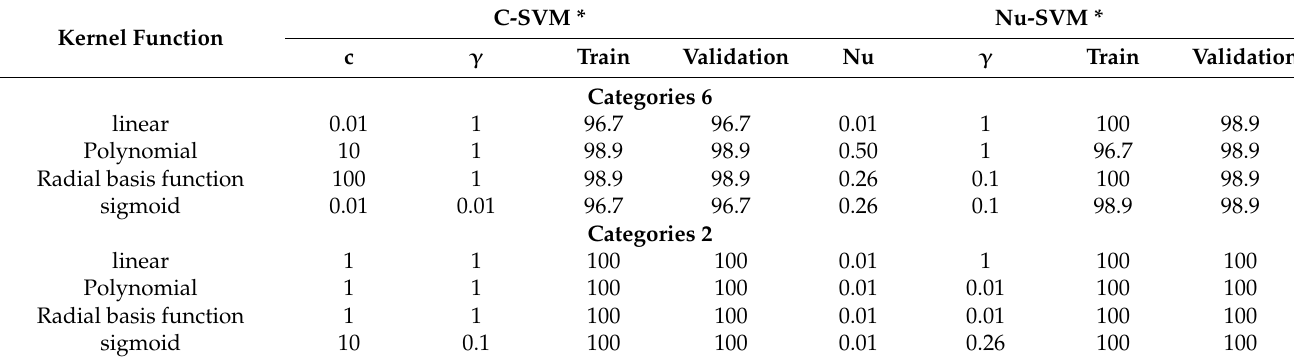
Table 5. Results and comparison of Nu-SVM and C-SVM models subjected to the kernel functions. C-SVM Kernel Function